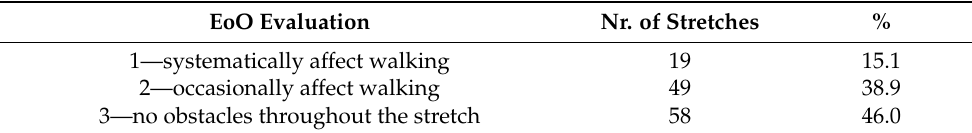
Table 6. Existence of obstacles (EoO).